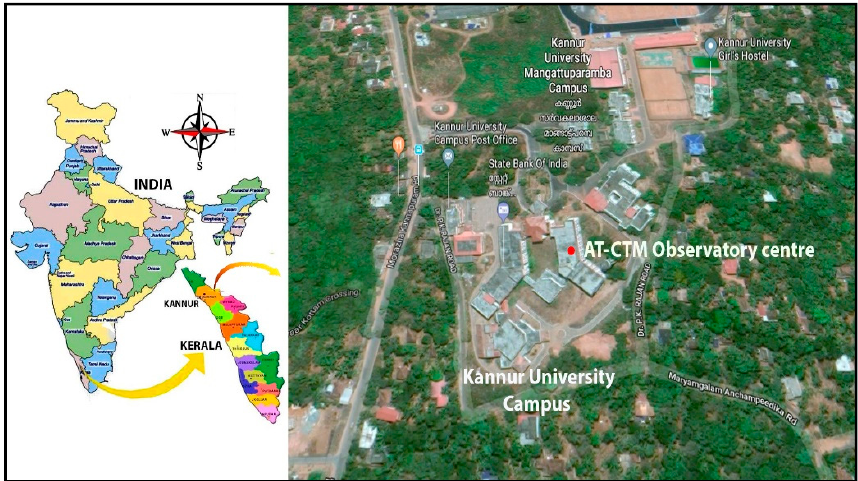
Figure 1. Location of observation